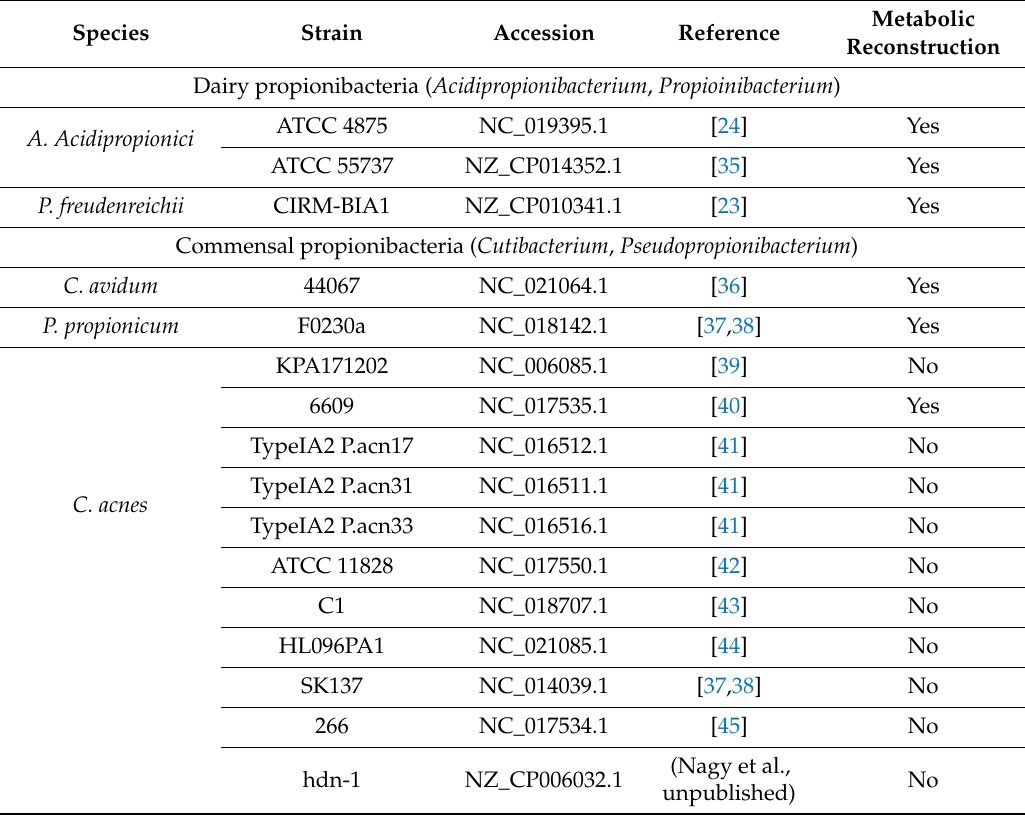
Table 1. List of strains with complete genomes used in the pan-genomic study and model